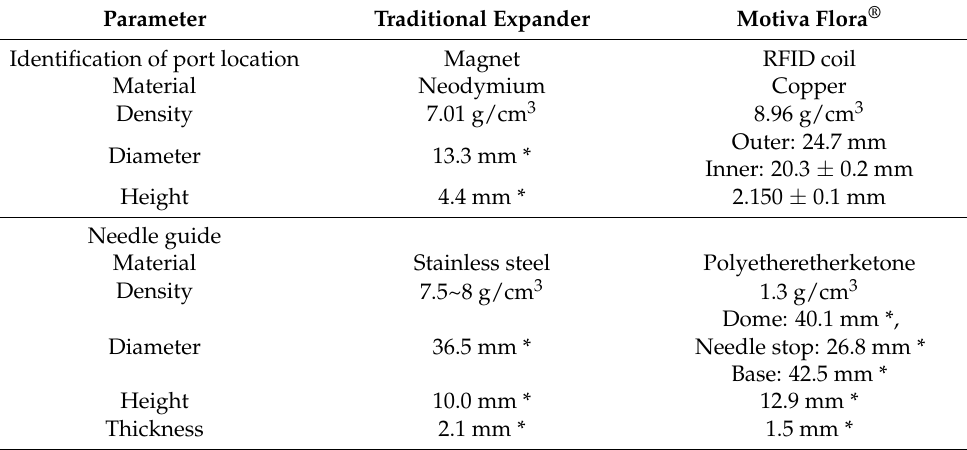
Table 1. Characteristics of breast tissue expanders. Parameter Traditional Expander Motiva Flora ® Identification of port location Magnet RFID coil Material